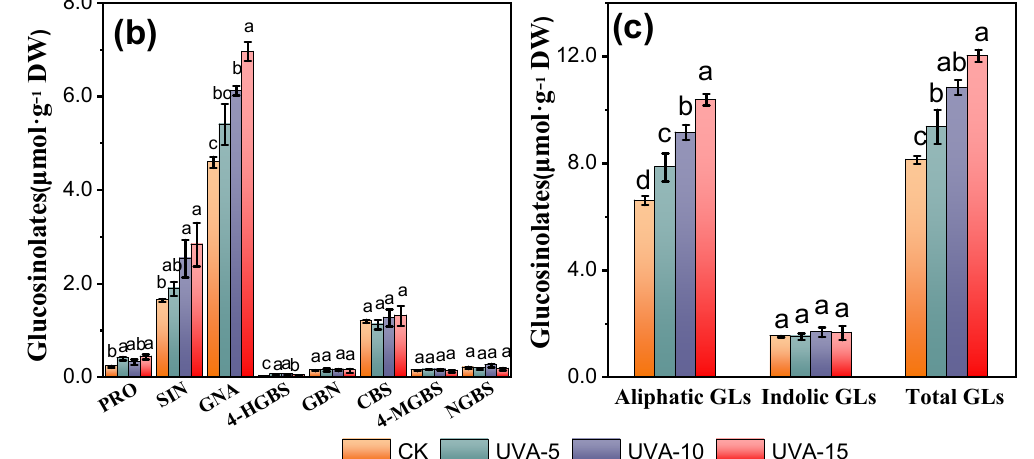
Figure 6. Glucosinolate composition and contents of Chinese kale baby-leaves under different supplemental UV-A intensities. The results presented were means ± standard error ( n = 3). Different letters ( a – c ) upon the bar plots indicate significant difference at p < 0.05 using one-way analysis of variance with Duncan’s multiple-range test.